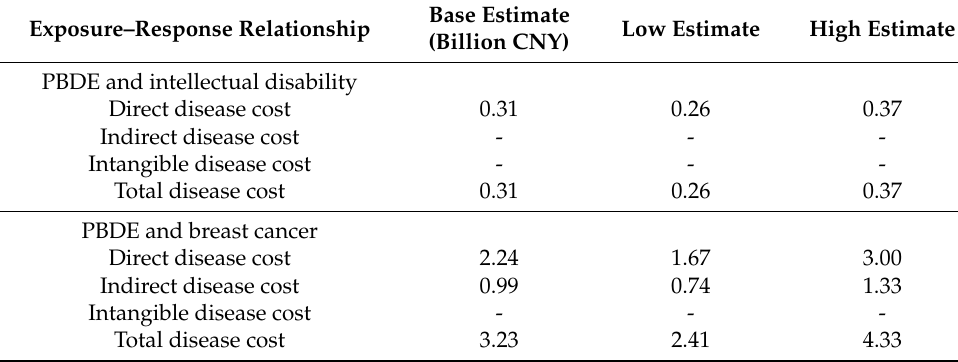
Chinese population